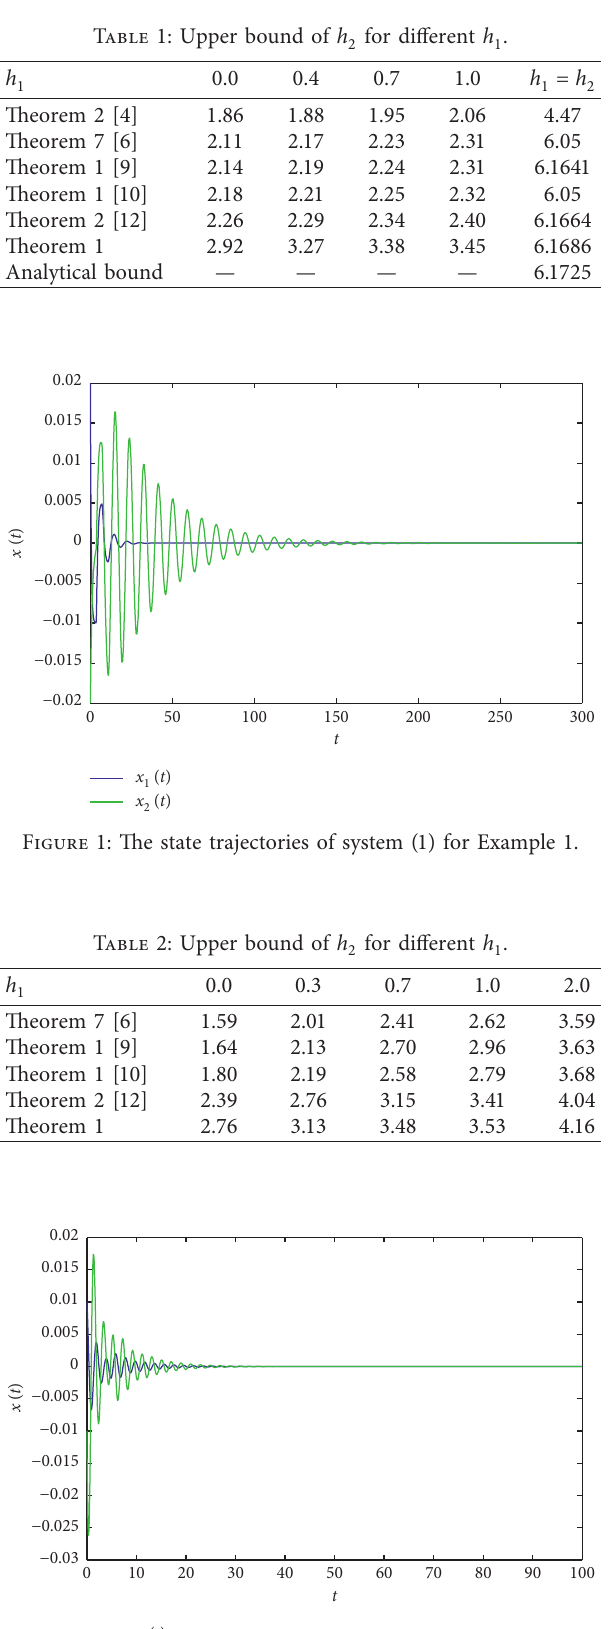
Table 1: Upper bound of h